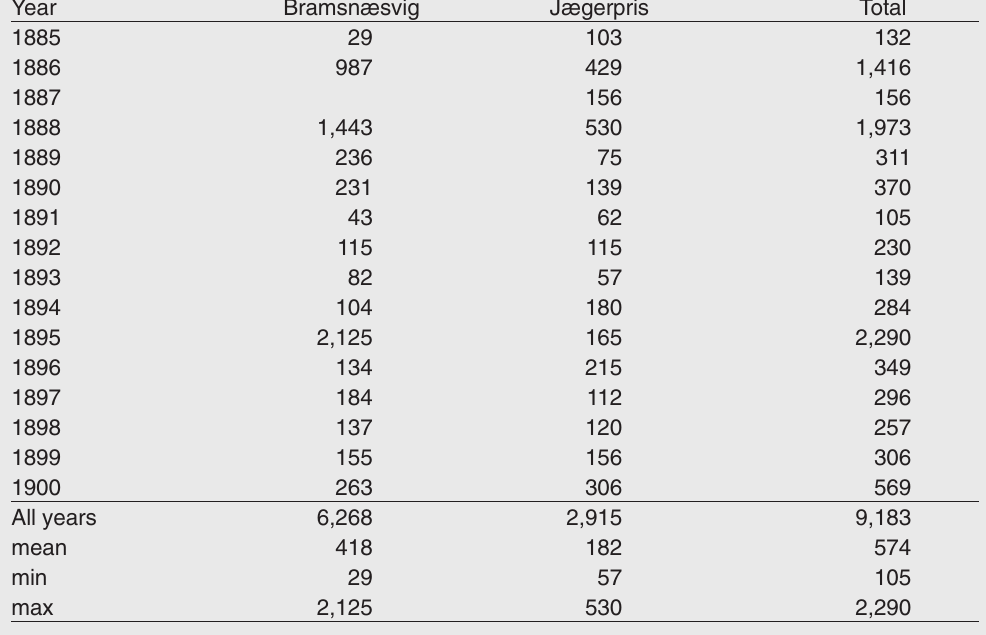
Table 2. Detailed historical logbook catch reports of harbour porpoises by year, in the Isefjord area.